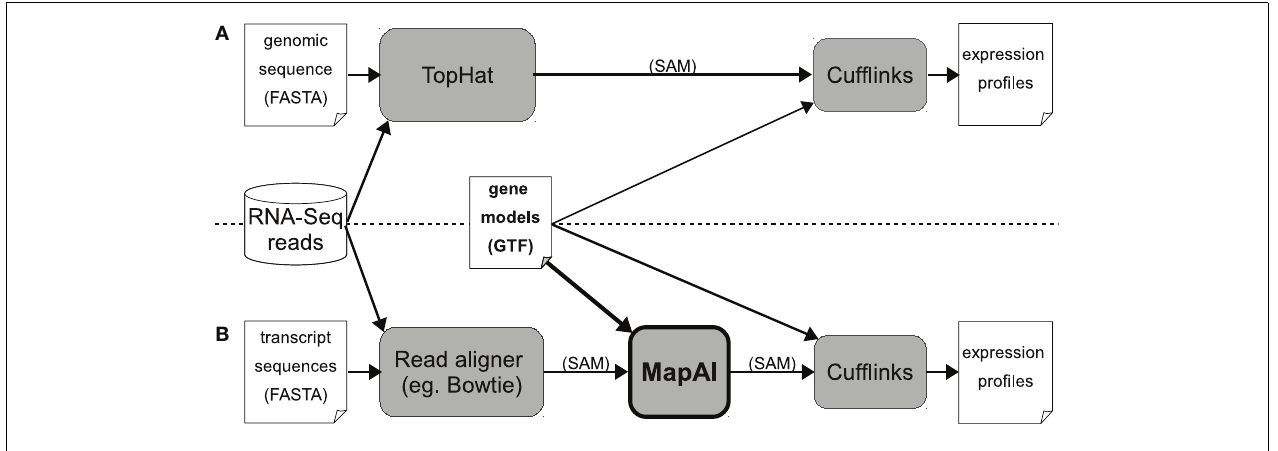
flow – alignments can be provided in SAM format (Sequence Alignment/Map), gene models in GTF (GeneTransfer Format), a refinement of the General Feature Format